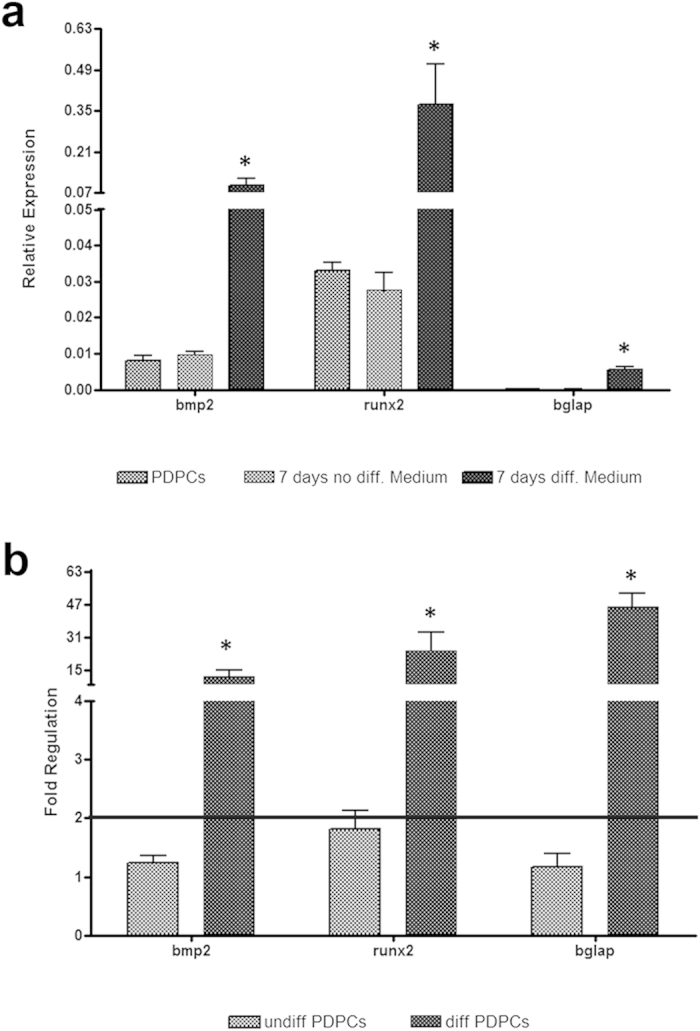
Histograms depict changes between PDPC basal gene expression (control) of bmp2, runx2 and osteocalcin (bglap) and that observed after culturing cells for 7 days on TCP either using DMEM/F12 non-differentiating medium or osteogenic differentiating medium. Data are expressed either as relative expression (a) or as fold-regulation with respect to PDPCs control (b), which represents fold-change results in a biologically expressive manner. In particular, the fold-regulation is equal to the fold-change (2−ΔΔCt) for fold-change values greater than one, which indicate an up-regulation. Fold-change values less than one indicate a down-regulation: in this case the fold-regulation is the negative inverse of the fold-change (−1/2−ΔΔCt). The black line in (b) indicates the range of physiological mRNA expression changes (i.e. fold-regulation < 2). Statistical differences between undifferentiated and differentiated PDPCs are denoted with an asterisk (* p < 0.05).